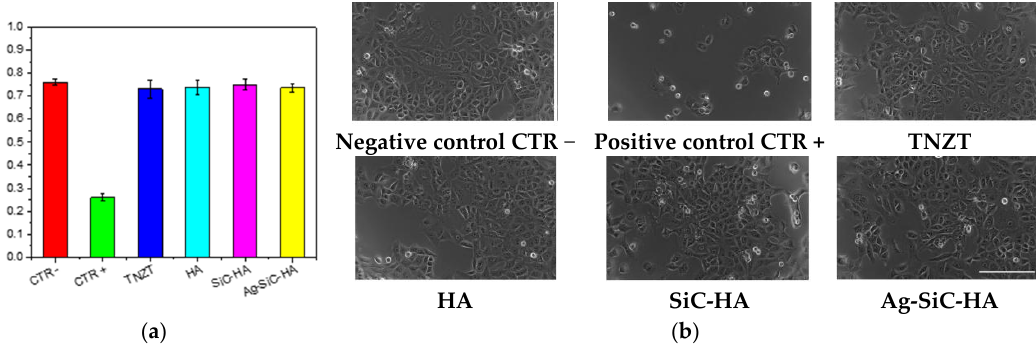
Figure 16. Comparative evaluation of metabolic activity of Vero cells grown for 24 h as negative control (CTR − ), positive control (CTR +) and with extraction media of the analyzed samples. Results are presented as means ±SEM (n = 3) ( a ); phase contrast micrographs of Vero cells cultured for 24 h in standard culture medium, culture medium supplemented with 5% DMSO and in sample’s extraction media ( b ). Scale bar represents 200 μ m.